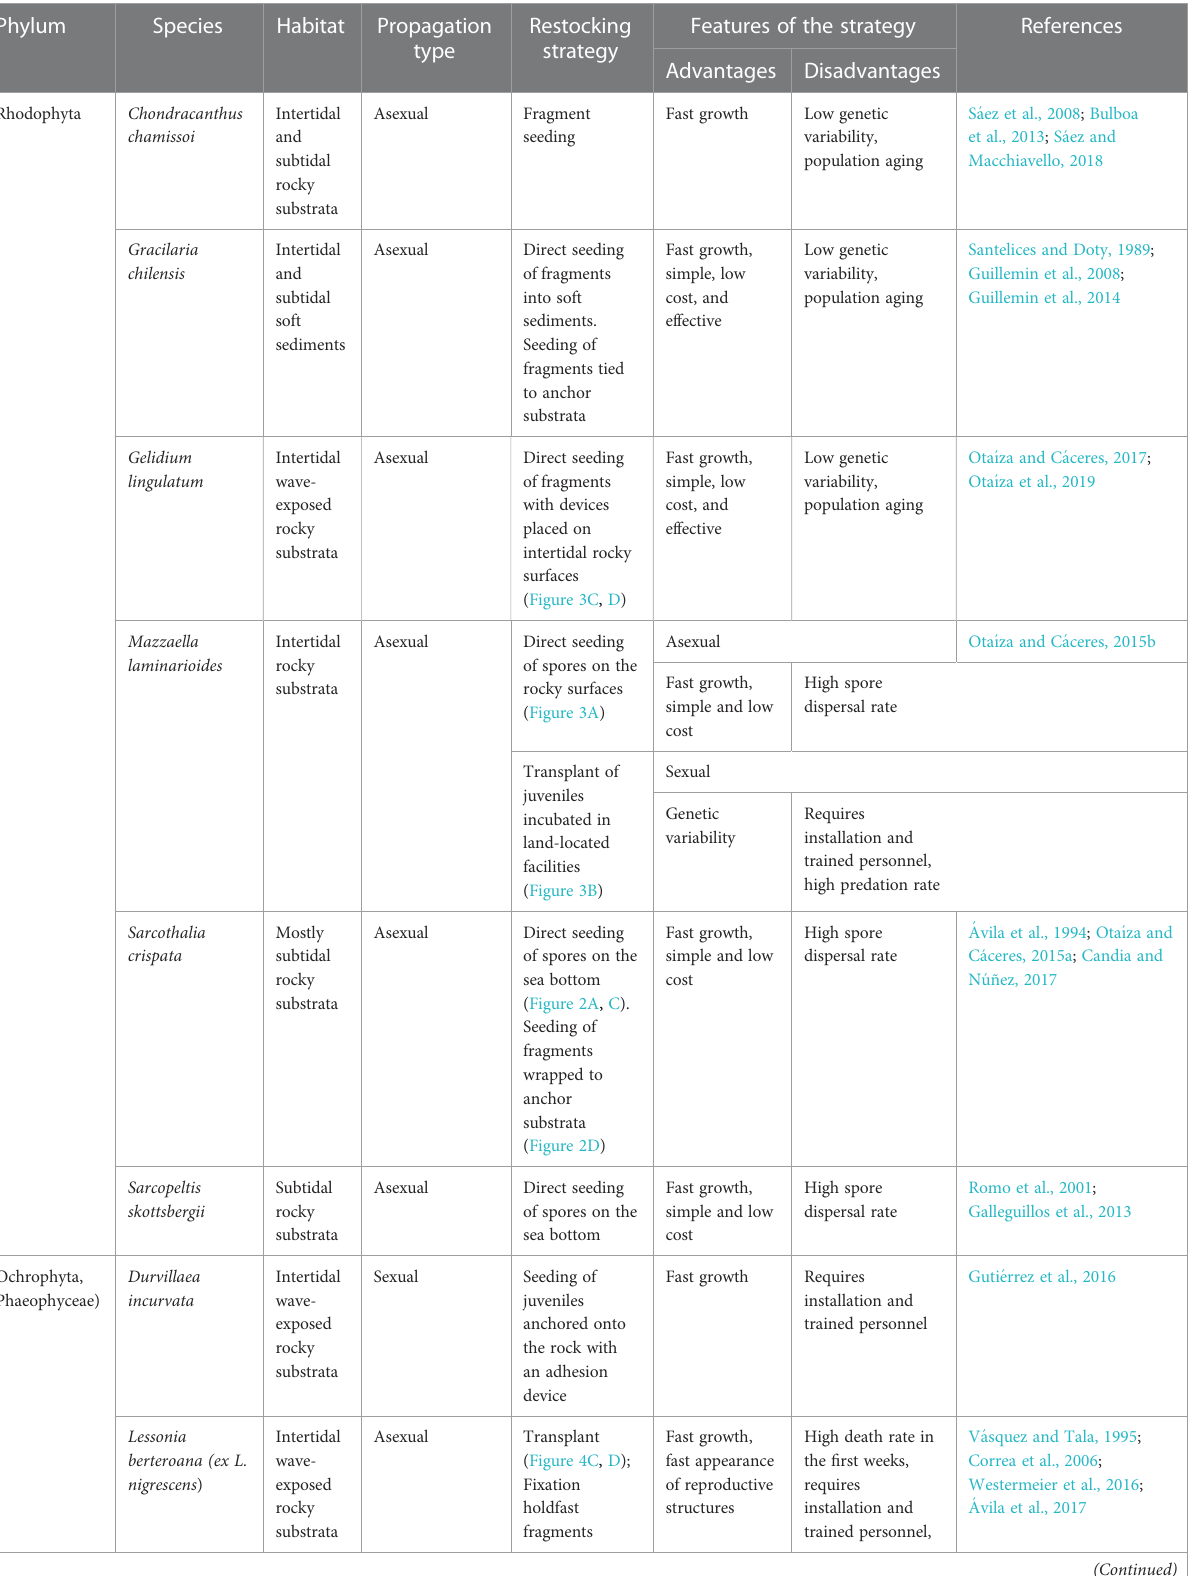
TABLE 2 Summary of main restocking strategies used in Chile, considering species; sexual or asexual propagation; and biological, technical, or economic advantages/disadvantages in each case.